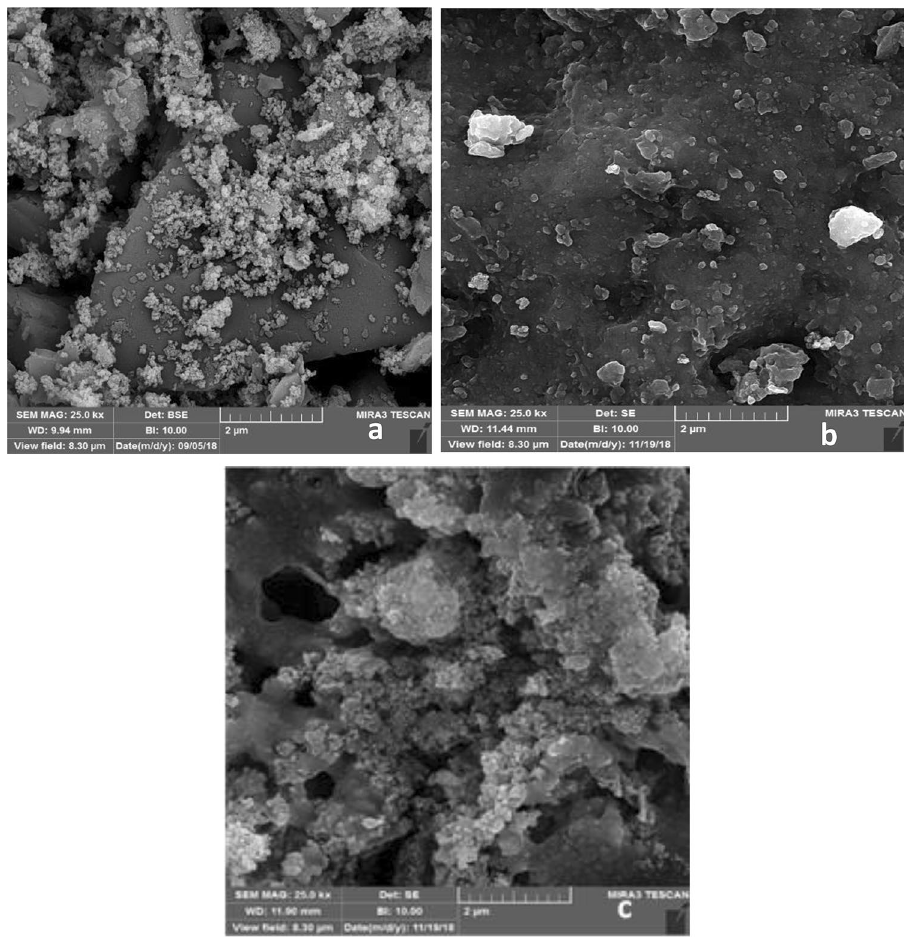
Fig. 4 The FE-SEM images of the coatings after sintering at a : 800 °C, b : 850 °C, and c : 900 °C